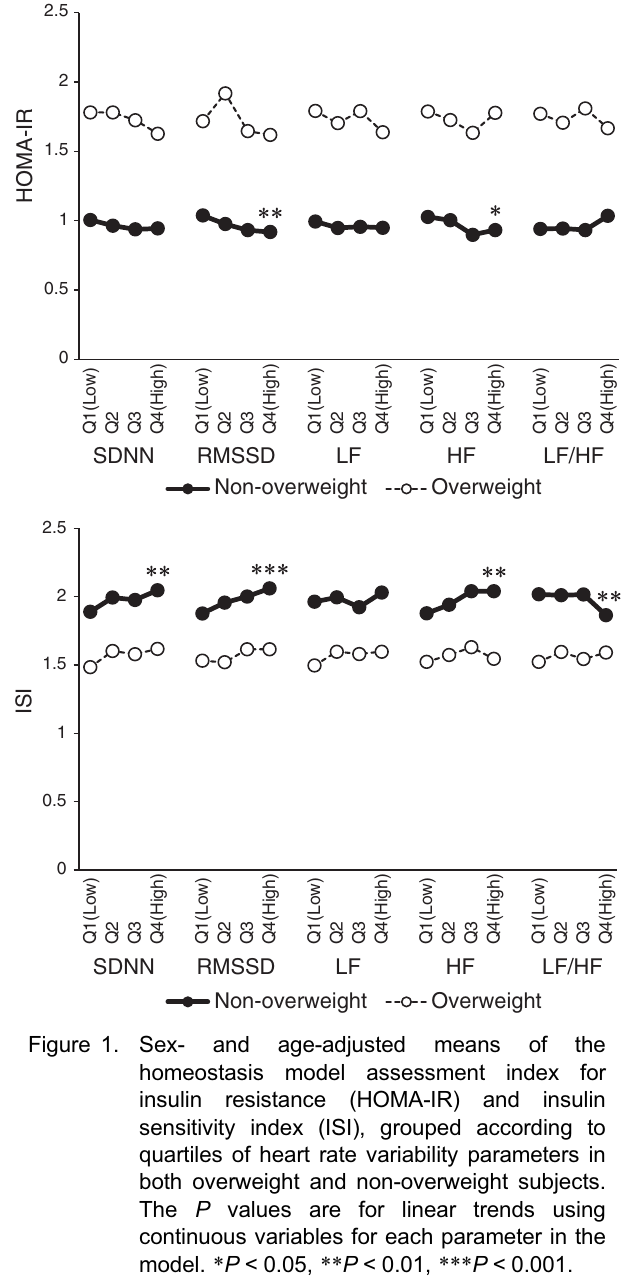
Figure 1. Sex- and age-adjusted means of the homeostasis model assessment index for insulin resistance (HOMA-IR) and insulin sensitivity index (ISI), grouped according to quartiles of heart rate variability parameters in both overweight and non-overweight subjects. The P values are for linear trends using continuous variables for each parameter in the model. * P < 0.05, ** P < 0.01, *** P <